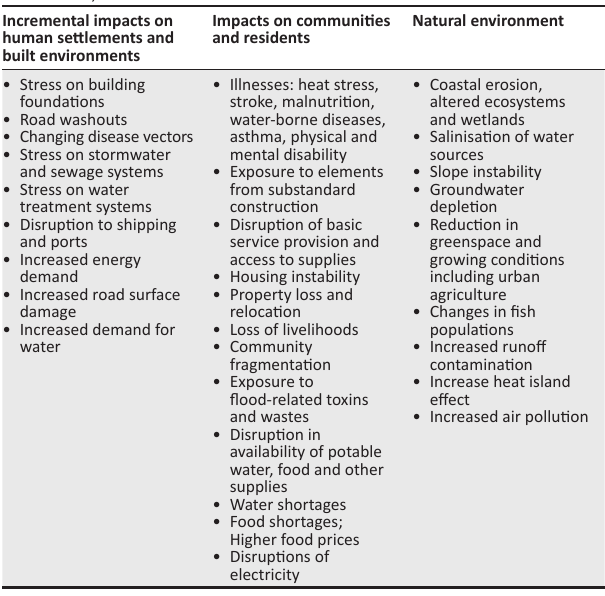
TABLE 1: Incremental impacts of climate change and natural hazards on human settlements, communities and residents. Incremental impacts on human settlements and built